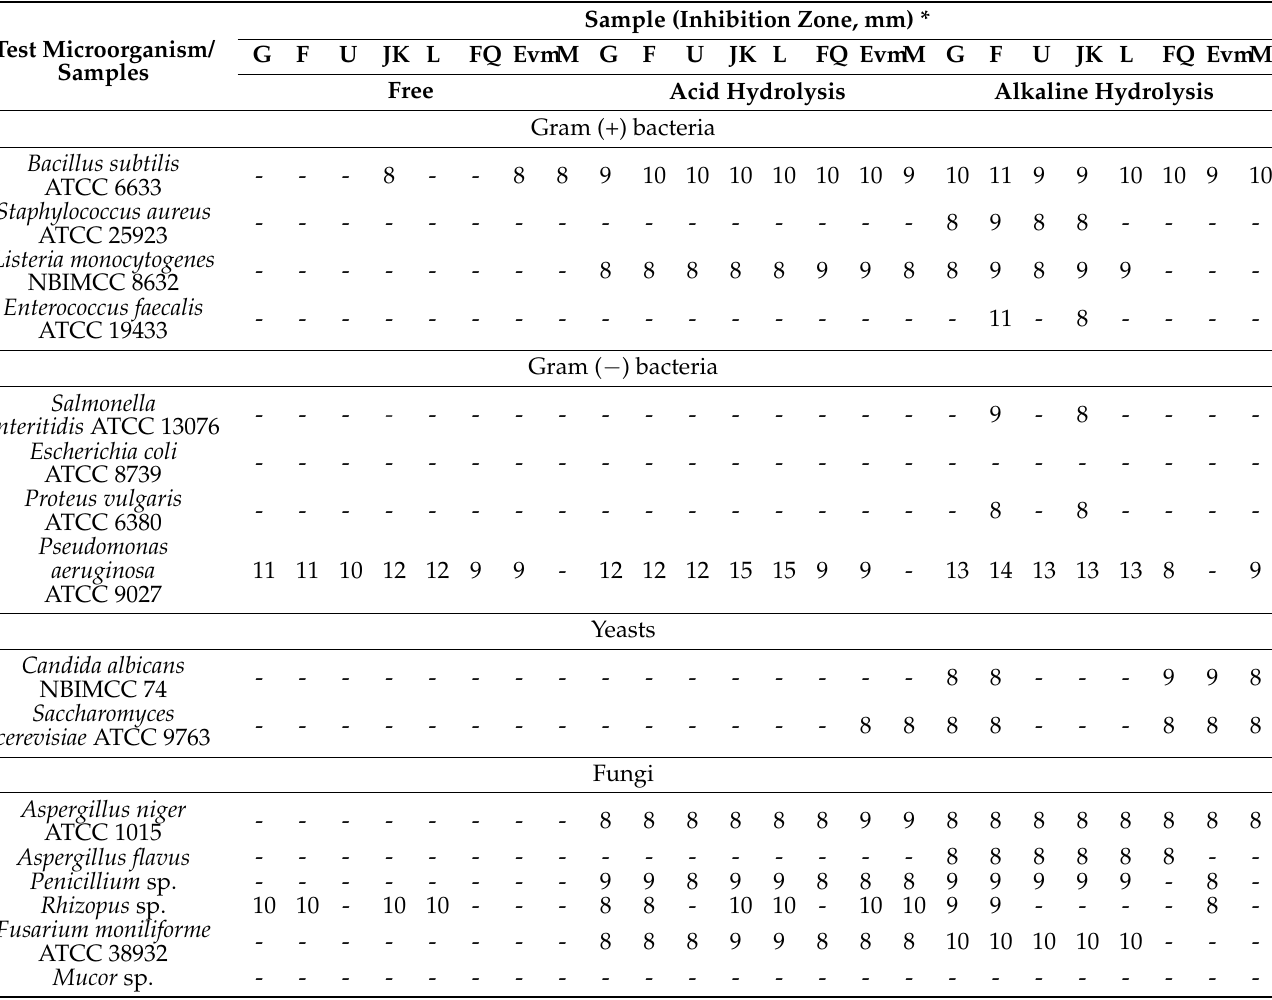
Table 3. Effect of free and bound phenolics of eight peach varieties’ peel extracts on antimicrobial potential toward bacteria, yeast and